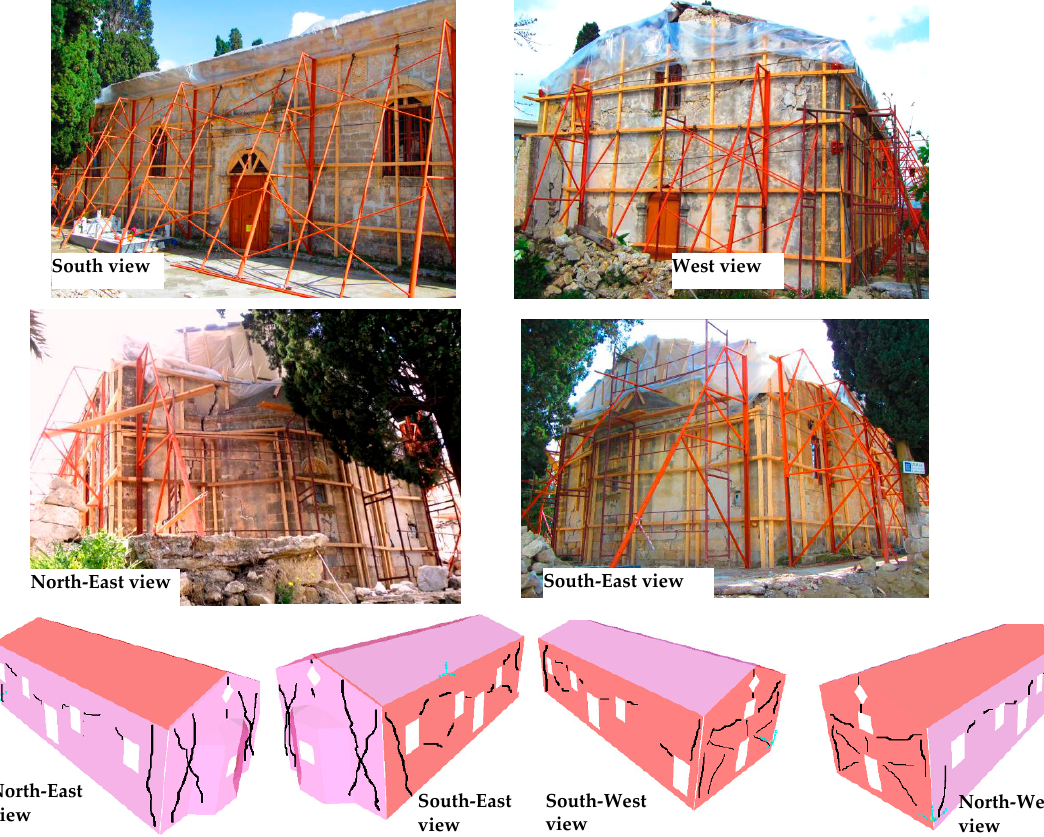
Figure 17. Photographs and sketches of the most severe structural damage.